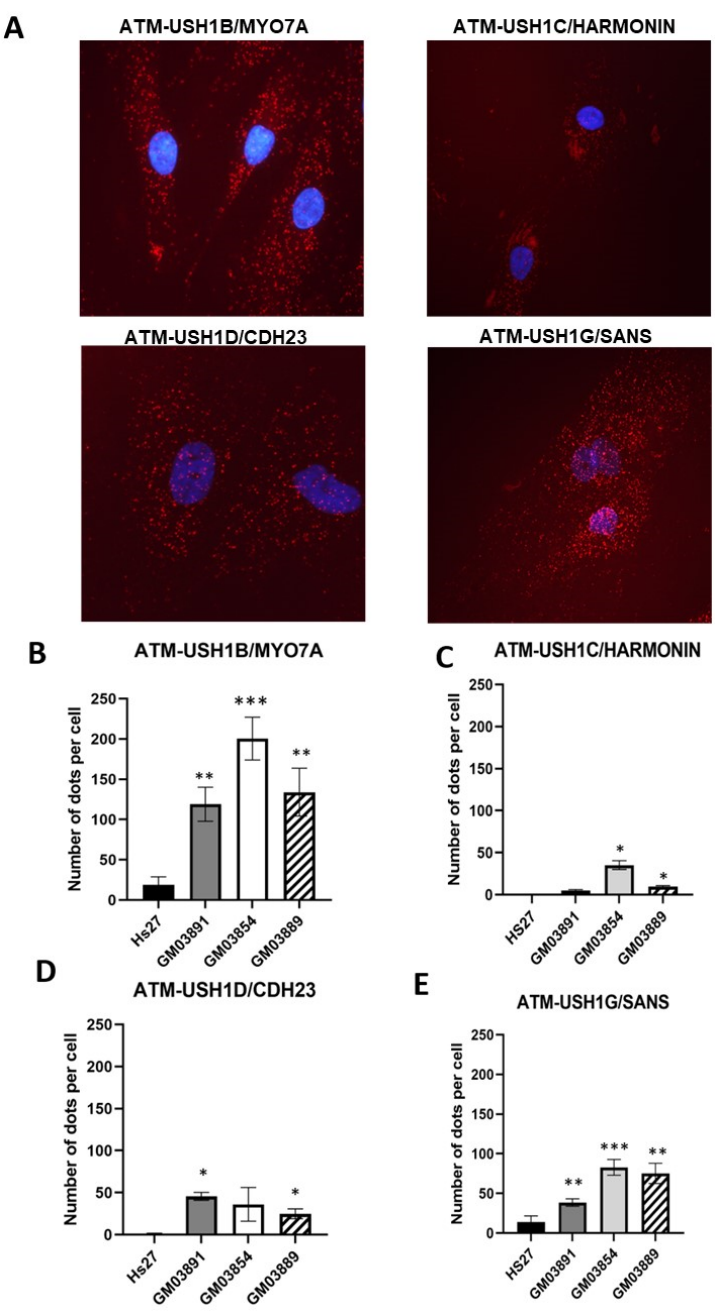
Figure 8. Interaction between ATM and USH1 proteins: A proximity ligation assay (PLA) was applied to the indicated cell lines. Representative PLA images obtained from GM03891 cells ( A ). Some nuclear PLA signals may be observed, but they do not represent the majority of ATM-USH1 protein complexes. The average numbers of red dots representing the cytoplasmic ATM-USH1 protein complexes were scored per 100 cells ( B – E ). Each datum represents the mean ± SEM of at least two independent replicates. The nuclei were counterstained with DAPI (blue). Asterisks represent the statistically significant differences from radioresistant controls, expressed as p -values (1, 2 and 3 asterisks correspond to p < 0.05, p < 0.01, and p < 0.001, respectively).